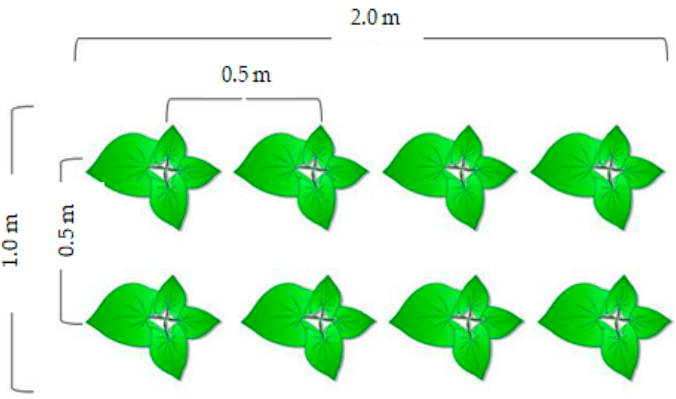
Figure 2. Planting tomatillo seedlings in plots.